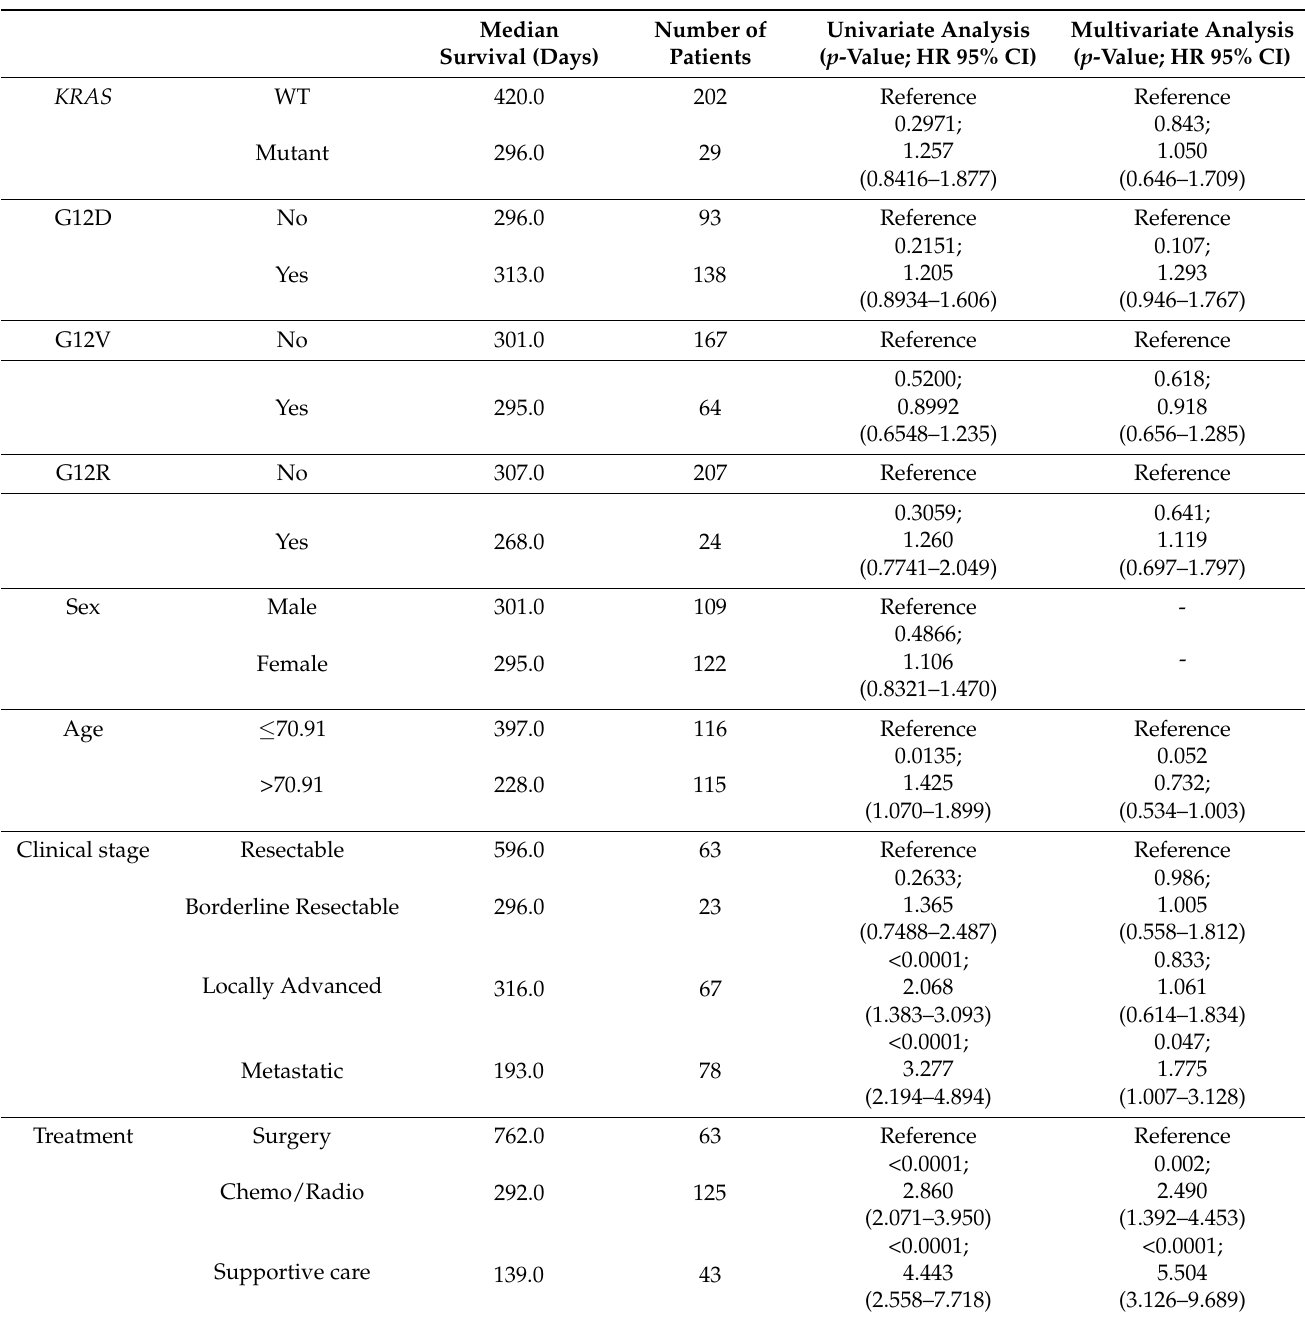
Table 4: Independent prognostic factors. Median survival and significance displayed for each group across whole cohort. The median age of the entire cohort was 70.91. G12D, G12V and G12R were compared with all other KRAS and KRAS wild-types. Univariate analysis performed using log-rank test; multivariate analysis performed using Cox proportional hazards model. Multivariate analysis for lymph node status, tumour location, neoadjuvant therapy, margin status and adjuvant therapy performed with the surgery group. WT, wild-type; HR, hazard ratio; 95% CI, 95% confidence